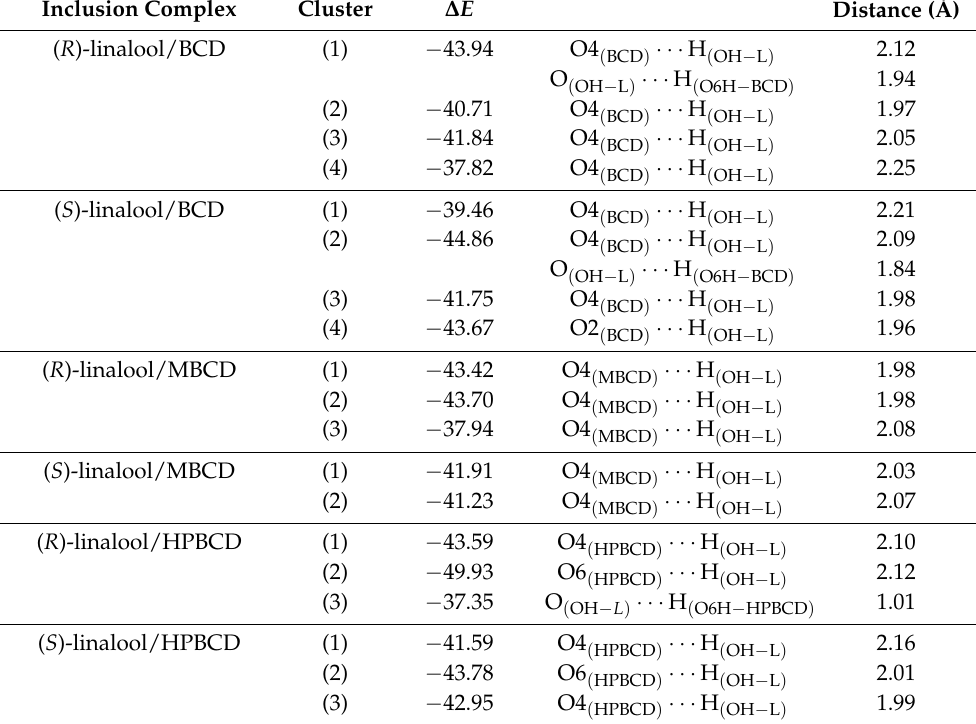
Table 4. The complexation energy ( ∆ E , in kcal/mol) and the distance of hydrogen bonds between linalool molecules (L) and three different CDs (BCD, MBCD, and HPBCD) molecules, obtained from PM7 minimized inclusion complex structures.